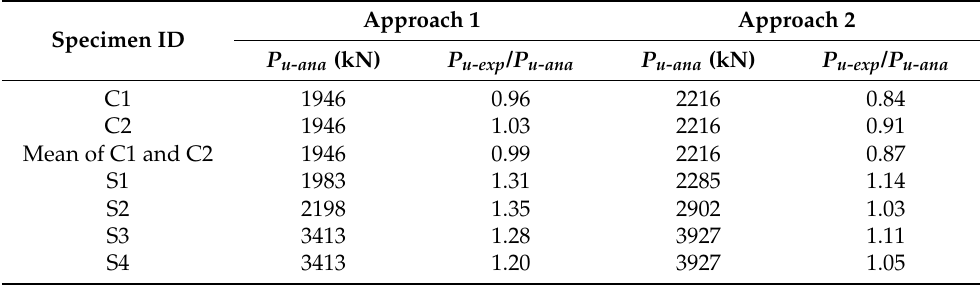
Table 5. Calculation of ultimate load of tested specimens by analytical models. Specimen